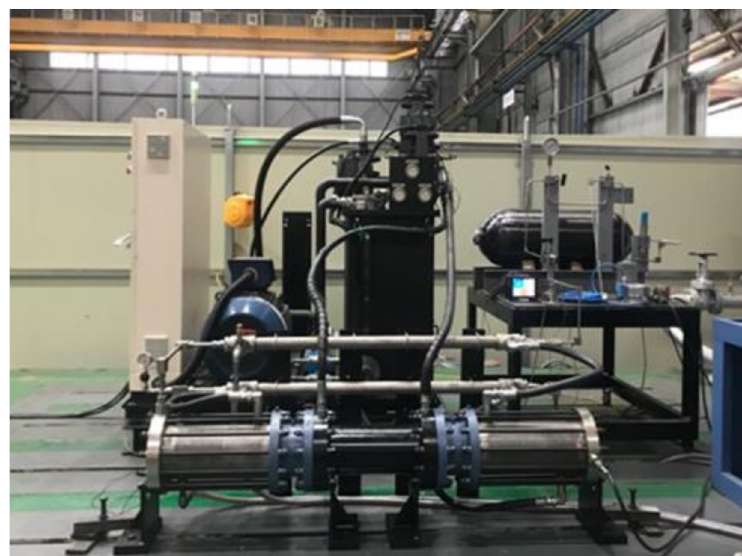
Figure 2. High-pressure tank for hydrogen storage